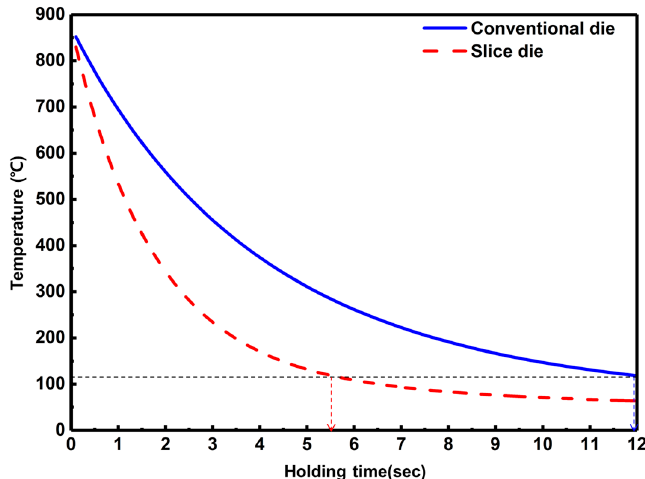
Figure 8. Maximum blank temperature of the conventional and slice dies according to holding time for the HPF process simulation.